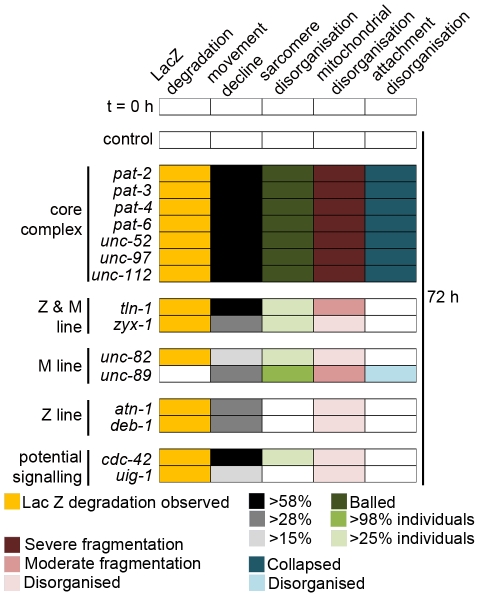
Acute loss of core integrin attachment complex members leads to collapse of attachments and multiple pathologies.Collapse of attachment complexes into ball like structures was assessed (Figure S3) and compared with the severity of other pathologies associated with attachment complex disruption (Figure 1, Figure 2, Figure 3, Figure 4, and Figures S1 and S2). Pathologies identified as significantly different from matched controls (t = 72 h, P<0.001 two way repeated measures ANOVA) were placed into identical groupings based upon severity of defect. In the case of the movement defect the extent of severity was established as follows. First, the core complex members were considered as a group and examined against the remaining components for lack of significant difference from any member of the group (t = 72 h, P>0.05 one way ANOVA). Next, the remaining components were examined for groups of components where a significant difference between individual components within a group of components did not exist (t = 72 h, P>0.05 one way ANOVA) but a significant difference between every member of the group and all other components did exist (P<0.01, one way ANOVA). Thus, the colour coding for the extent of pathology as displayed in the inset legend reflects statistically significant differences in severity of defects.